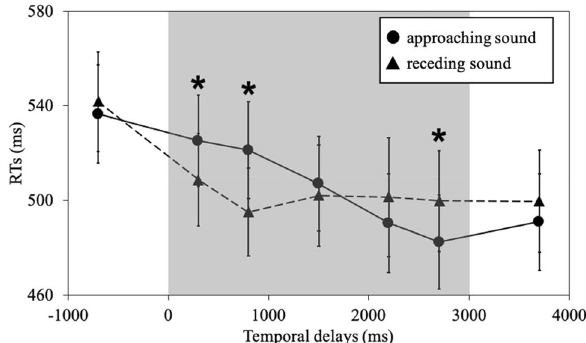
Figure 3. The results of the Experiment RTs (ms) as a function of the temporal delays (ms). The four direction conditions (front, rear, left, and right) were merged. The description of the figure is the same as in Fig. 2. The error bars represent standard errors. Asterisks represent significant differences ( p < .05) between the RTs for the approaching sound and the receding sounds as a result of multiple comparisons (Shaffer’s modified sequentially rejective Bonferroni